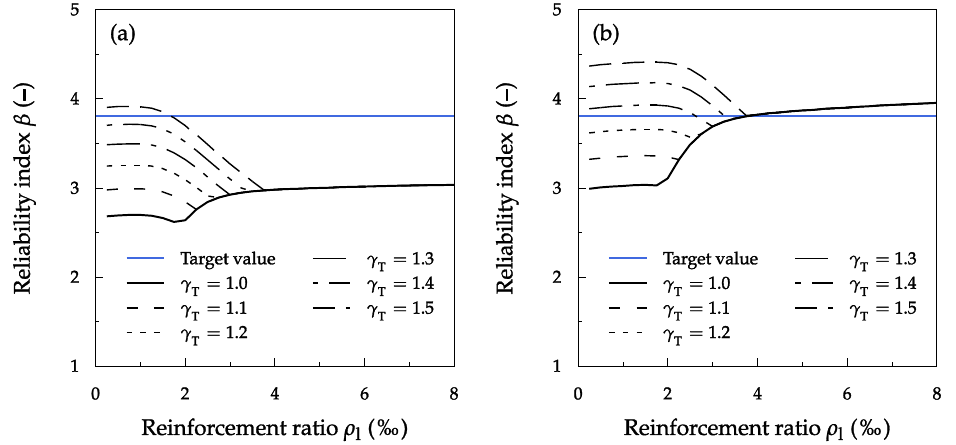
Figure 12. Reliability indices calculated according to FORM: ( a ) effective depth d = 15 mm; ( b ) effective depth d = 60 mm.